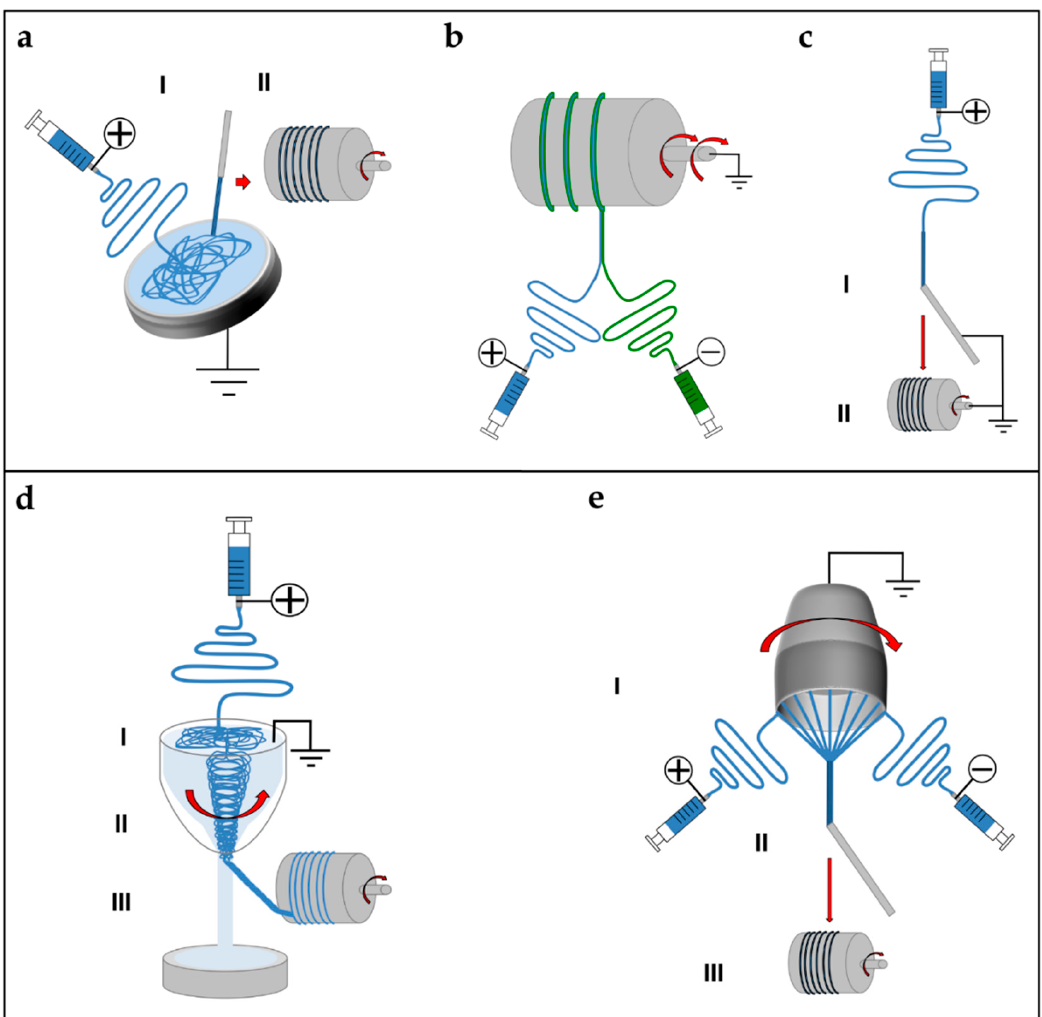
Figure 6. Different electrospinning setups to produce continuous bundles or yarns of nanofibers. ( a )